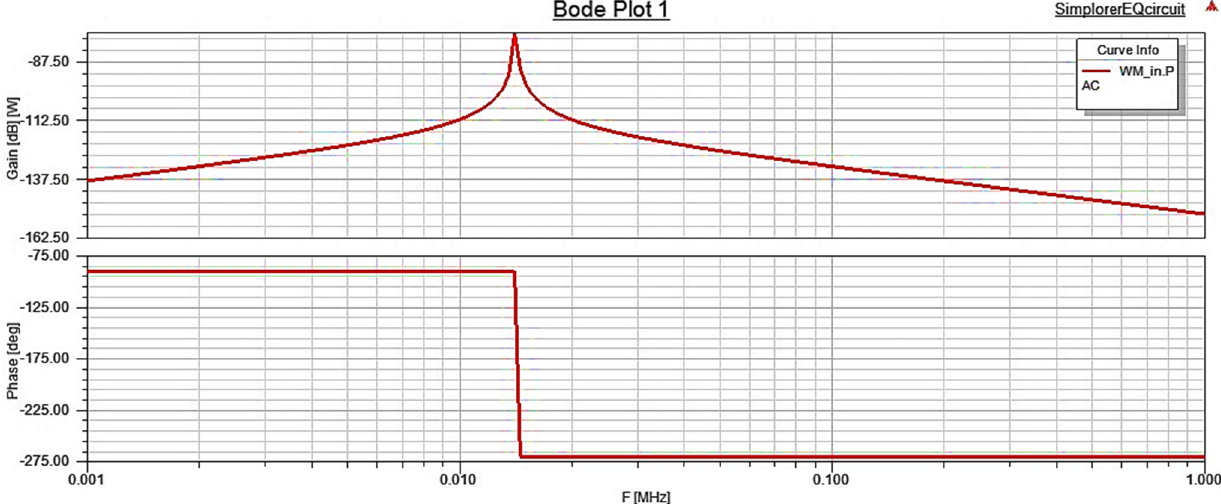
Figure 5. Equivalent circuits: Bode efficiency vs. Frequency.